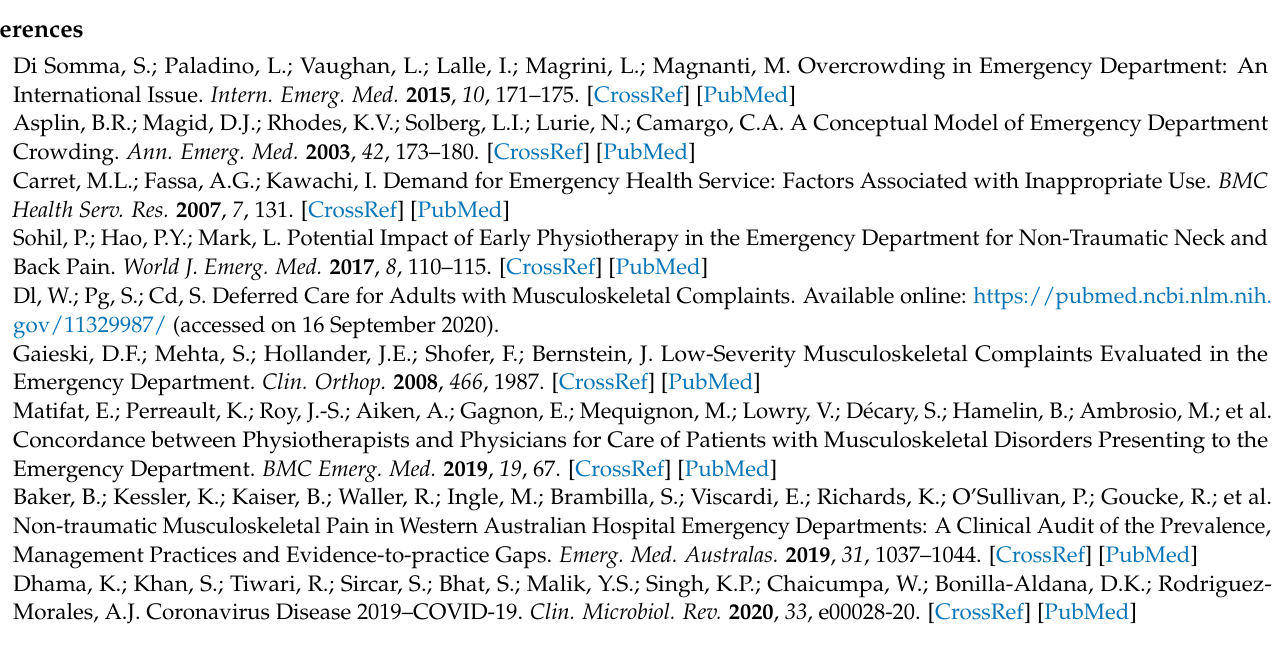
Figure A1. Evaluation survey of patients accessing the ED with a diagnosis of non-traumatic, low- severity musculoskeletal conditions.